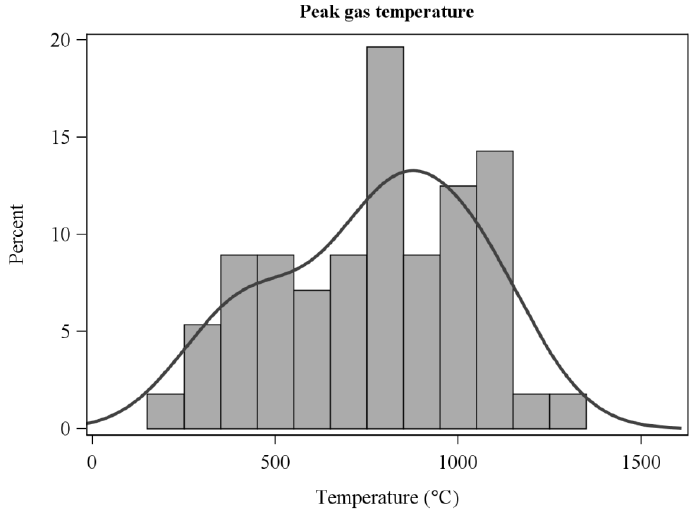
Figure 4 Figure 4. Frequency distribution of peak gas temperatures within residence times measured with fine